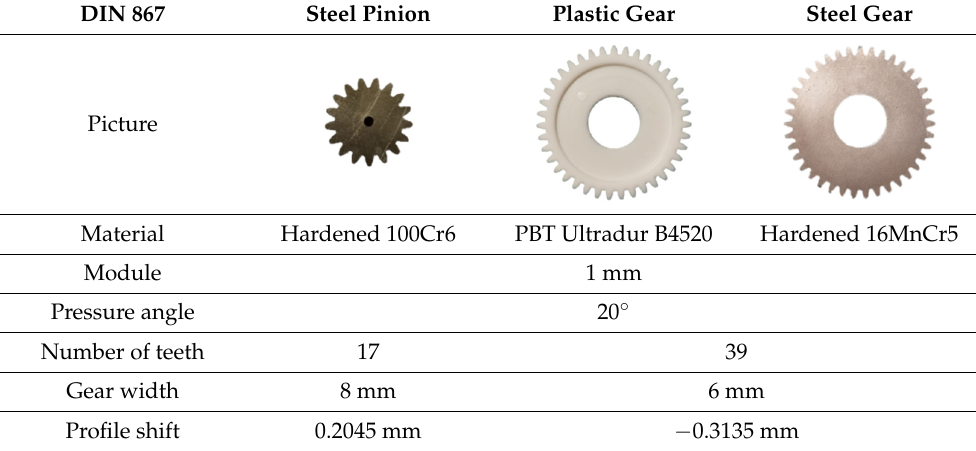
Table 1. Technical specifications of the investigated gear sets. DIN 867